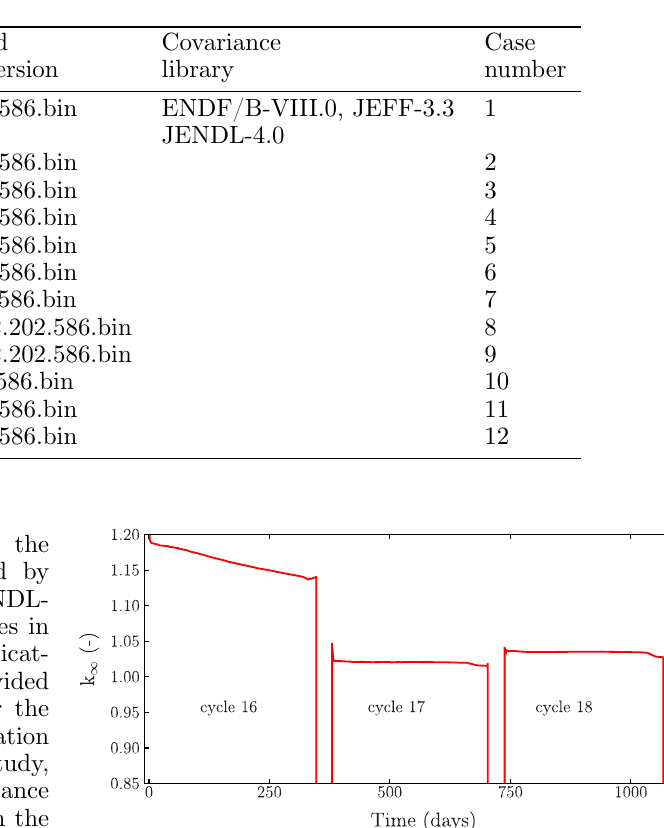
Table 1. Summary of the different CASMO5 calculation schemes performed in the present study for the two- dimensional GU3 calculations.